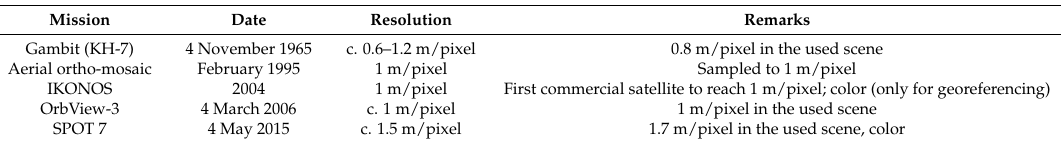
Table 1. Imagery used in this study.